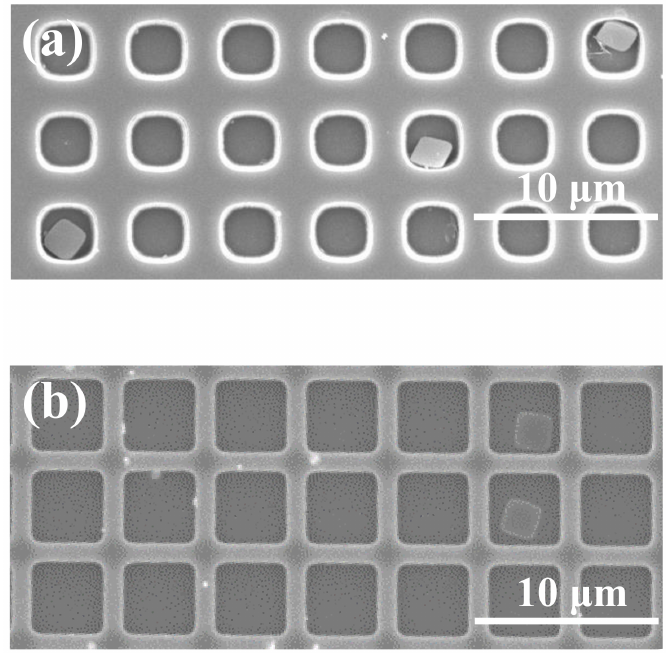
Figure 5. Typical plane-view scanning electron microscope images of ( a ) the SiO 2 -terrace receiver and ( b ) the reference receiver.